Question: Name the type of graph shown.
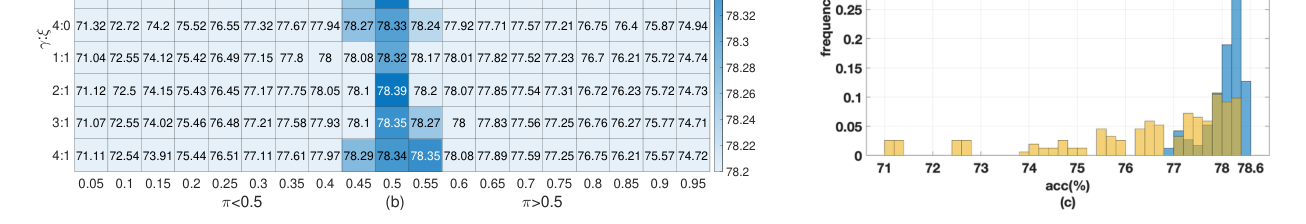
Answer: histogram